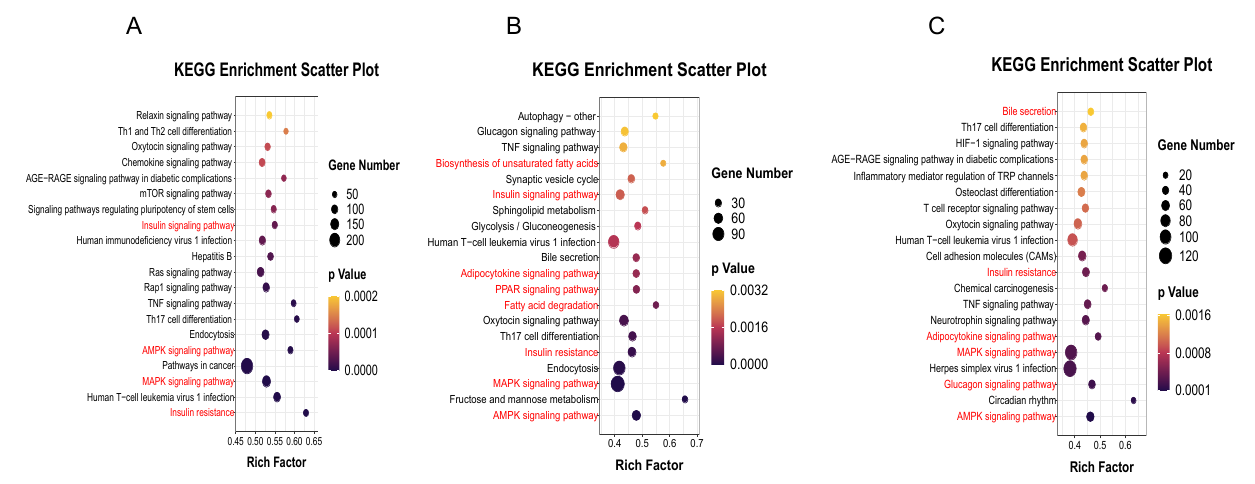
Figure 5. KEGG enrichment analysis of tsRNA target genes. Increased ( A ), significantly increased ( B ), and significantly decreased ( C ) tsRNA target gene KEGG signaling pathway enrichment